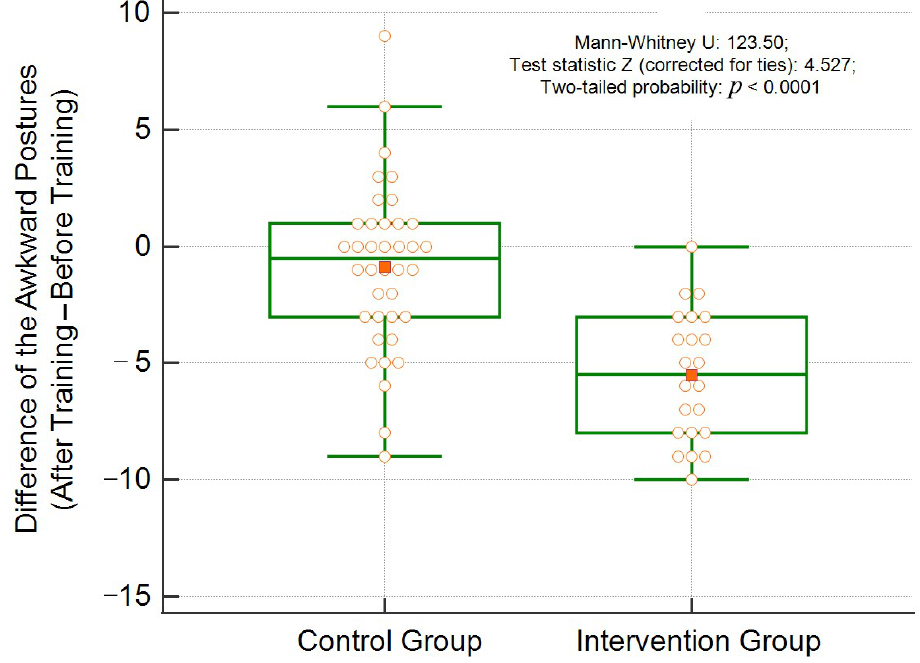
Figure 5. Distribution of the difference between the scores of awkward postures after and before training, according to the groups.